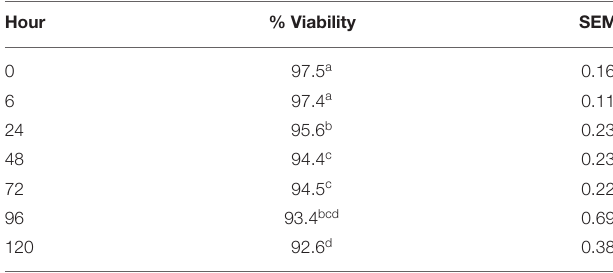
TABLE 1 | Porcine stomachs ( n = 3) were collected from a local abattoir and 4-mm punch biopsies of antral mucosal explants were cultured over 120h in